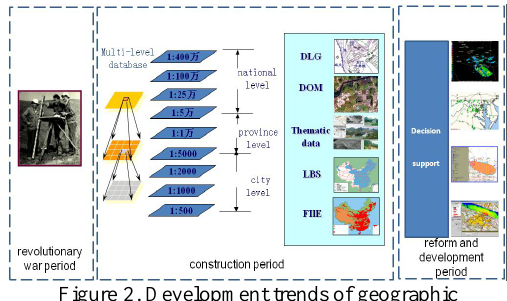
Figure 2. Development trends of geographic information